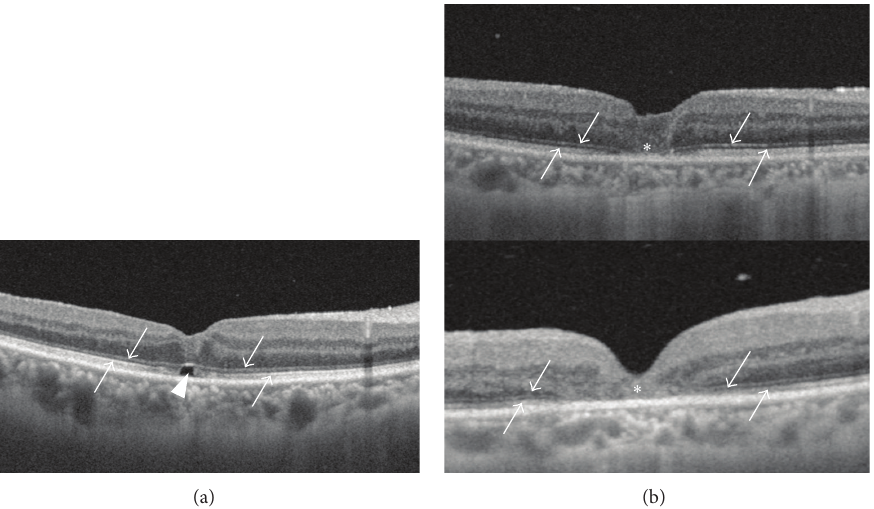
Figure 1: Macular OCT images of a patient who was included in the study (a) and excluded from the study (b). (a) The ellipsoid zone (EZ; up arrow) is disrupted with foveal detachment (arrowhead) beneath a continuous external limiting membrane (ELM; down arrow). (b) Both the EZ (up arrow) and the ELM (down arrow) are disrupted at the fovea (asterisk). Foveal detachment is not observed.